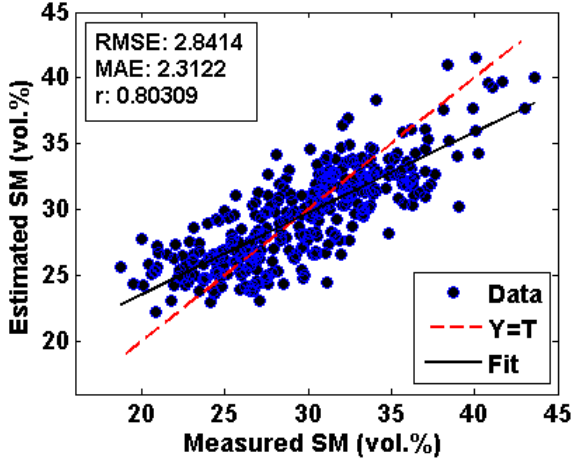
Figure 6. The relationship between the measured and estimated soil moistures (SM) for Dataset